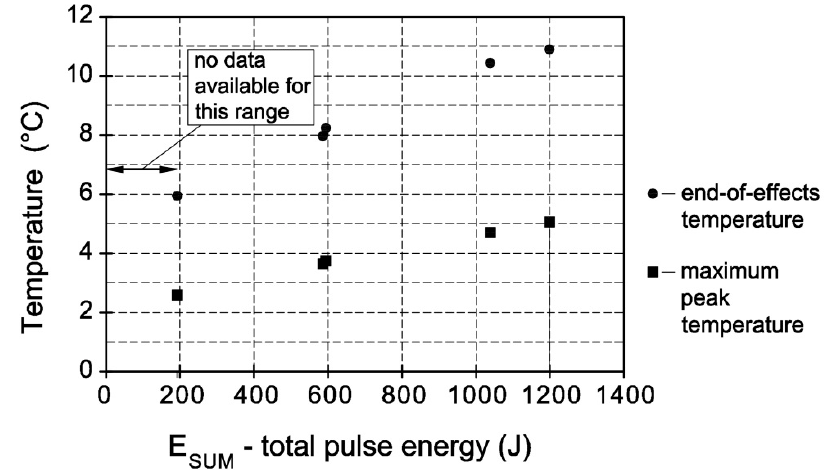
Figure 2. Relationship between the peak maximum and end ‐ of ‐ effects temperature against the total energy of a single thermal pulse.